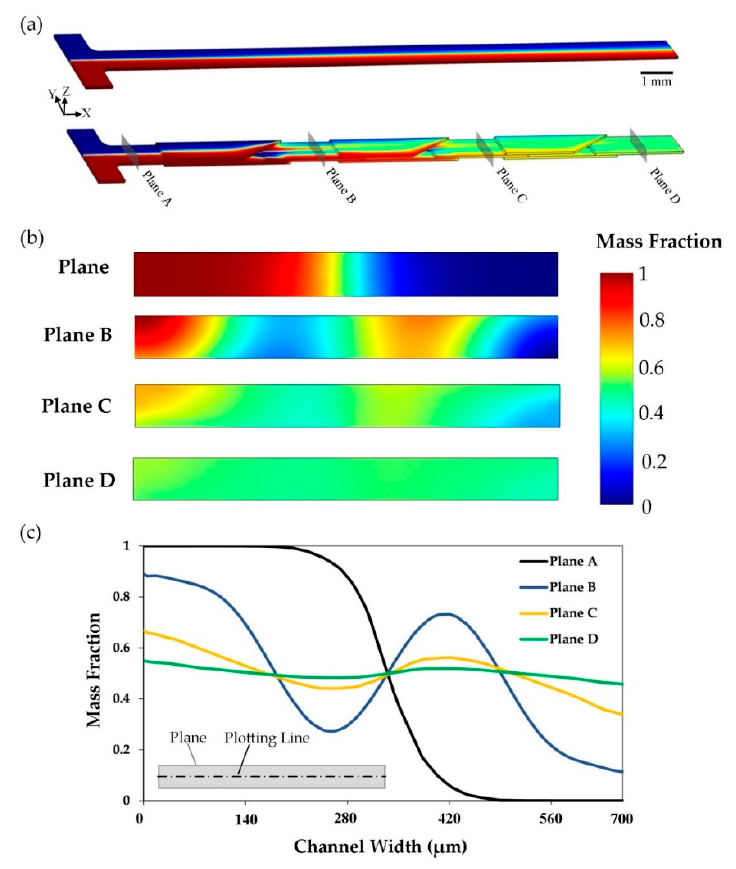
Figure 6. Numerical simulation of the mixing process (micromixer type A). ( a ) Comparison of mixing performance of the proposed design and a straight channel with same cross section size and boundary conditions (Re = 0.1). ( b ) Mas fraction distributions at the inlet and after each mixing unit are illustrated. Location of the planes is shown on the micromixer. ( c ) Plot of mass fraction along an imaginary line middle of the above-mentioned planes. Schematic position of the plotting line is illustrated.